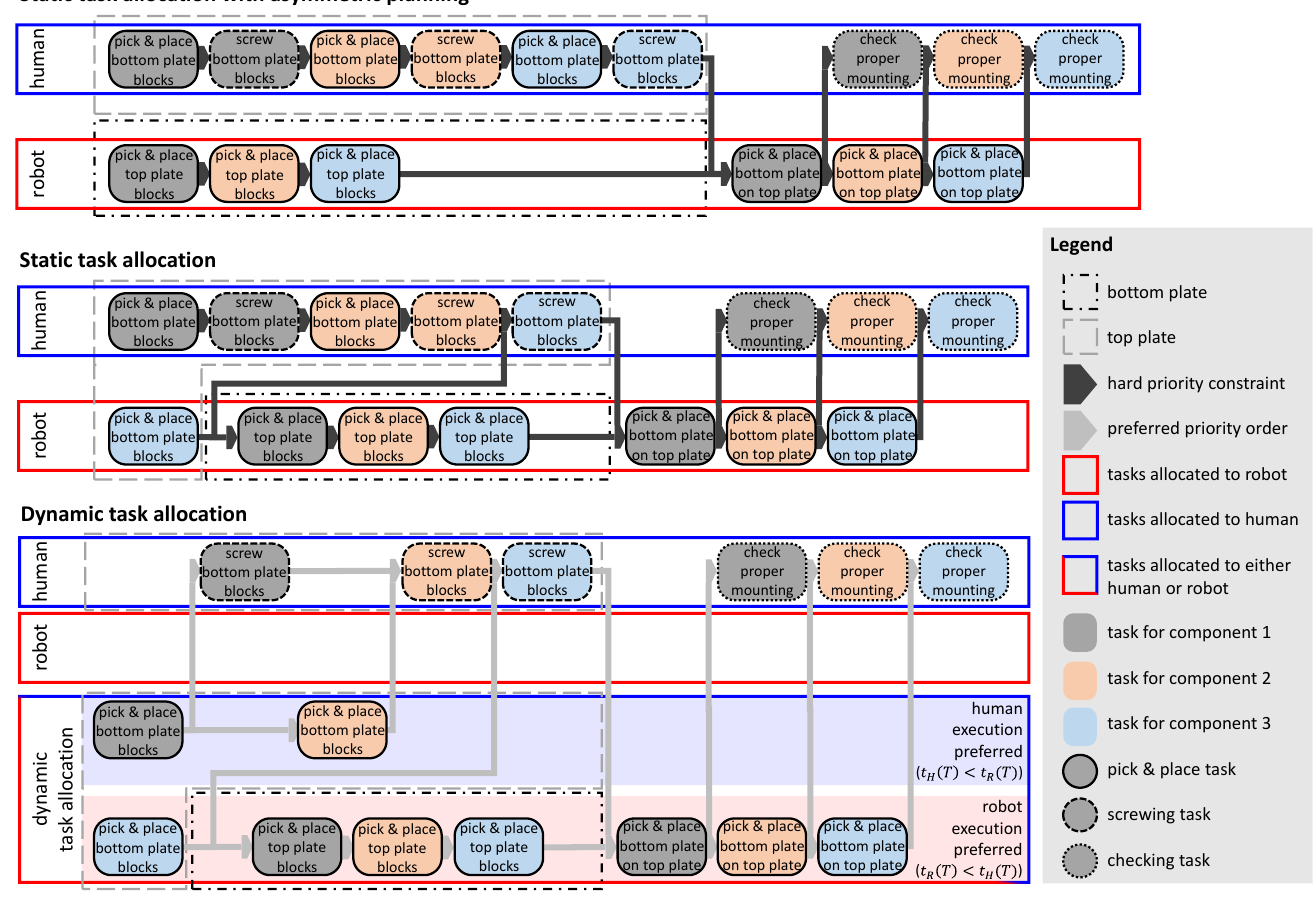
Figure 14. Assembly sequences for the implemented task allocation modes in human-robot collaboration.